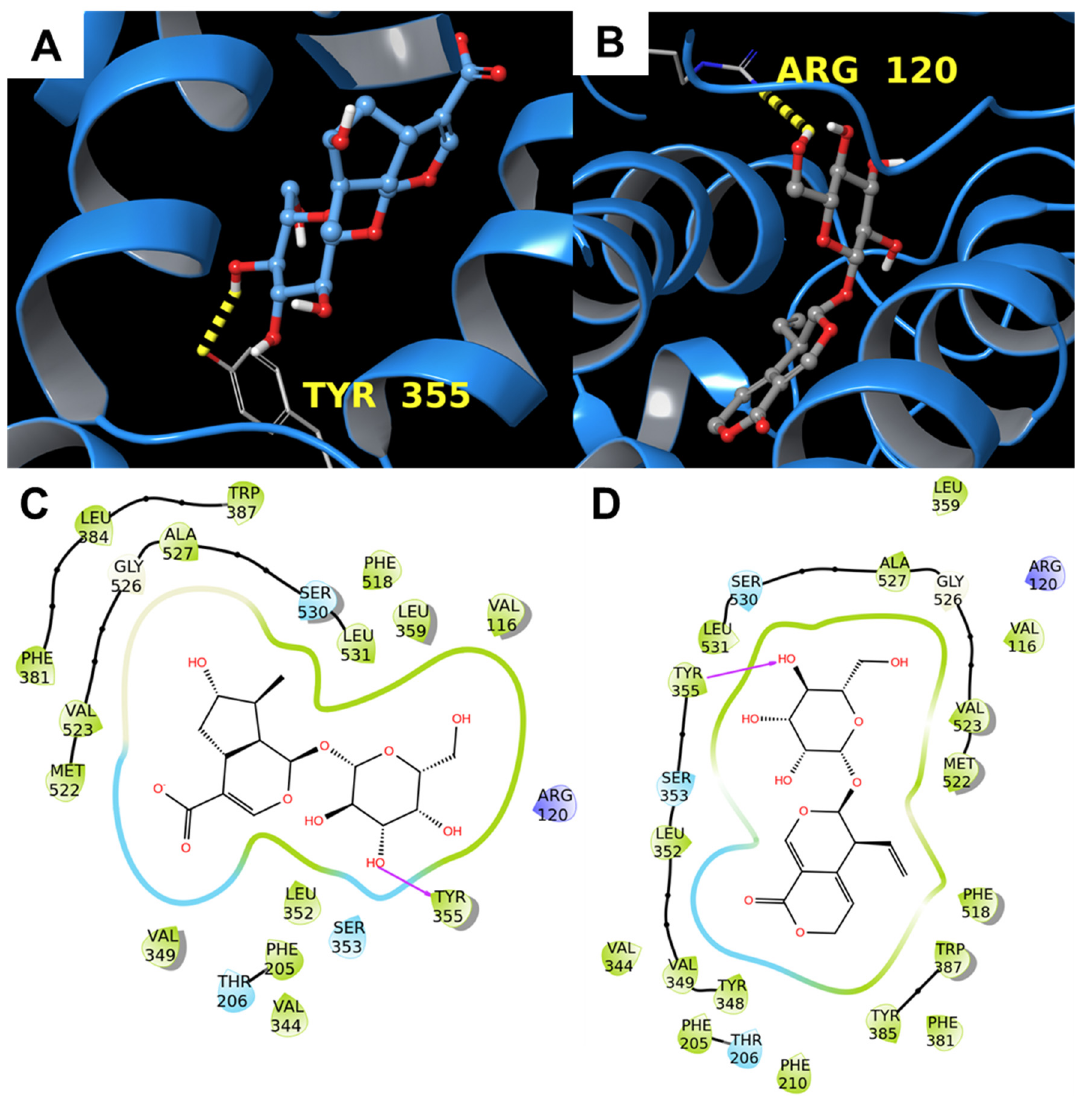
Figure 5. Molecular docking results. ( A , B ) 3D binding mode of 1 ( A ) and 2 ( B ) with COX-2 (PDB: 1DDX [44], cyan ribbons). Hydrogen bonds are represented by yellow dotted lines. ( C , D ) 2D representation of the binding pose of 1 ( C ) and 2 ( D ). Pink arrows represent hydrogen bonds.